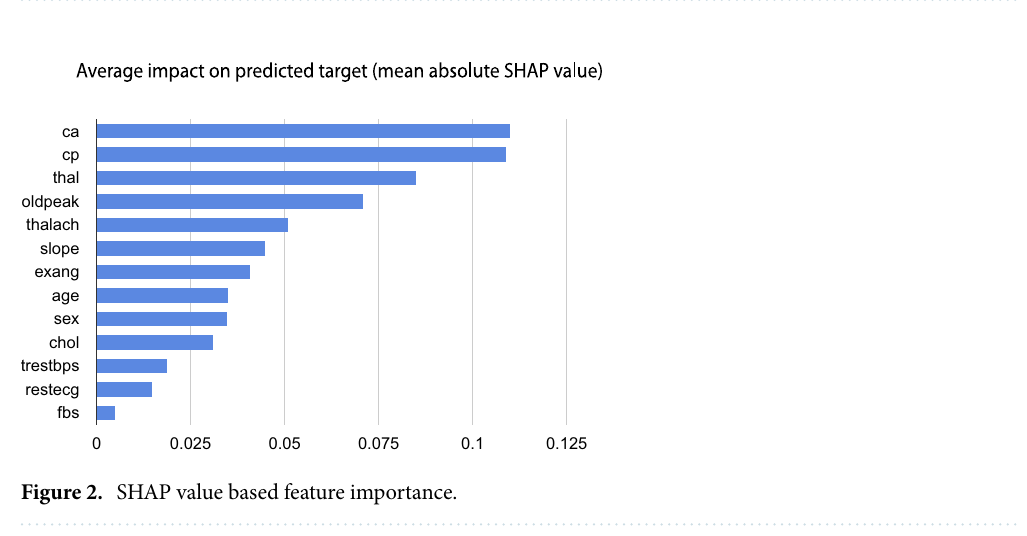
Table 4. Spearman correlation outcomes.